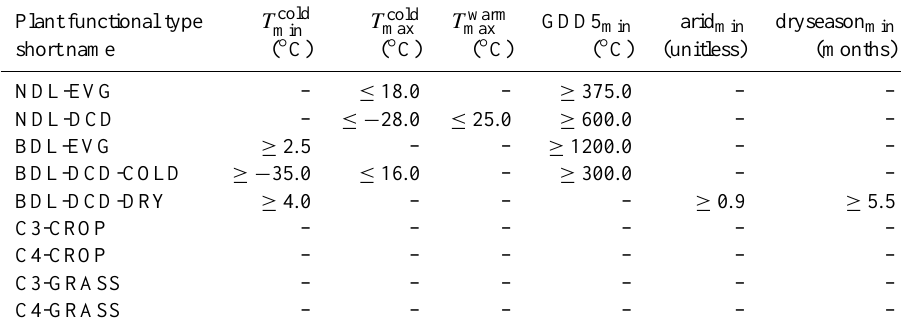
Table 2. Bioclimatic limits used in the competition parametrization of CTEM v. 2.0 as described in Sect. 2.1.4. T cold minimum and maximum coldest month temperatures, respectively. T warm max is the maximum warmest month temperature, GDD5 min is the minimum growing degree days above 5 ◦ C (GDD5), arid min is the minimum aridity index and dryseason min is the minimum length of the dry